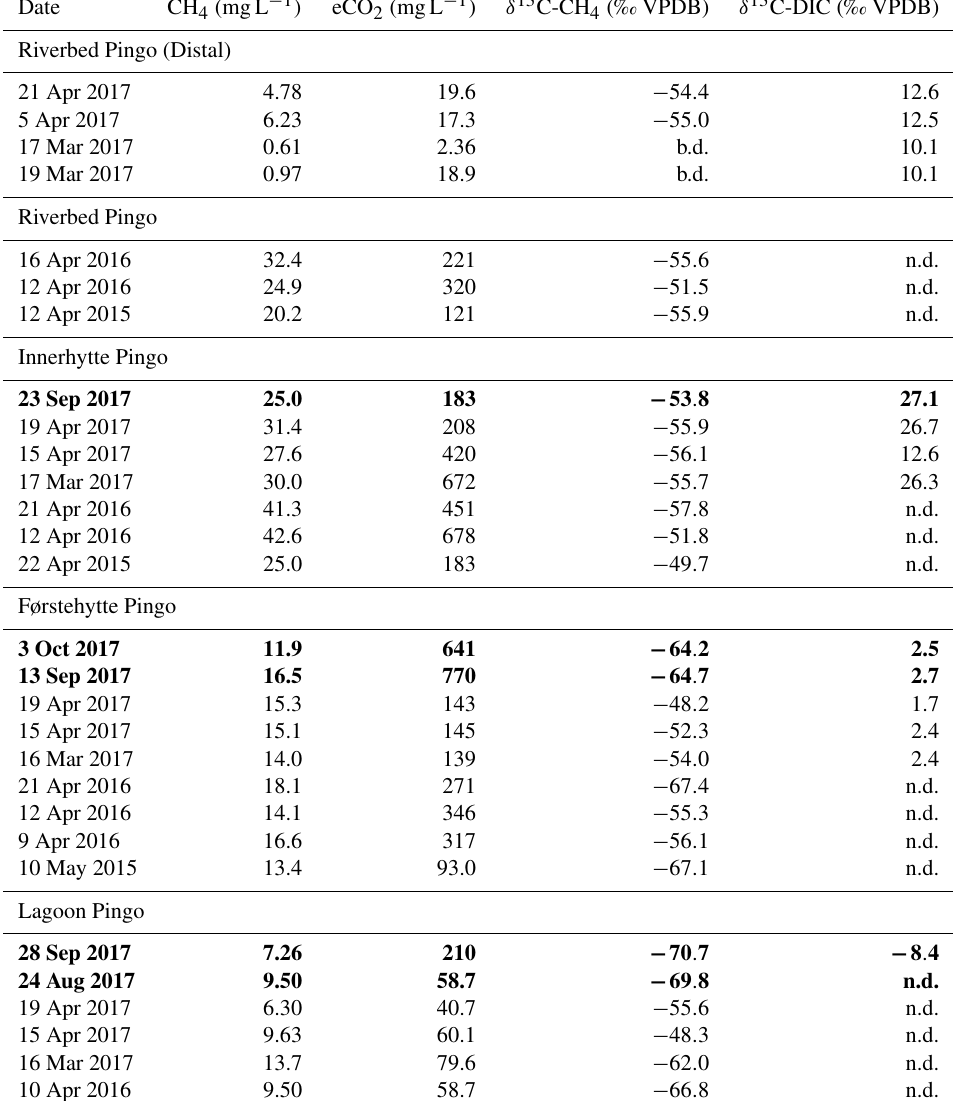
Table 2. The δ 13 C composition and concentration of methane and dissolved inorganic carbon (DIC) in pingo springs. The excess of CO 2 relative to equilibrium with the atmosphere is “eCO 2 ”. Samples collected opportunistically during the summer are in bold, “n.d.” means “not determined, and “b.d.” means results were below the detection